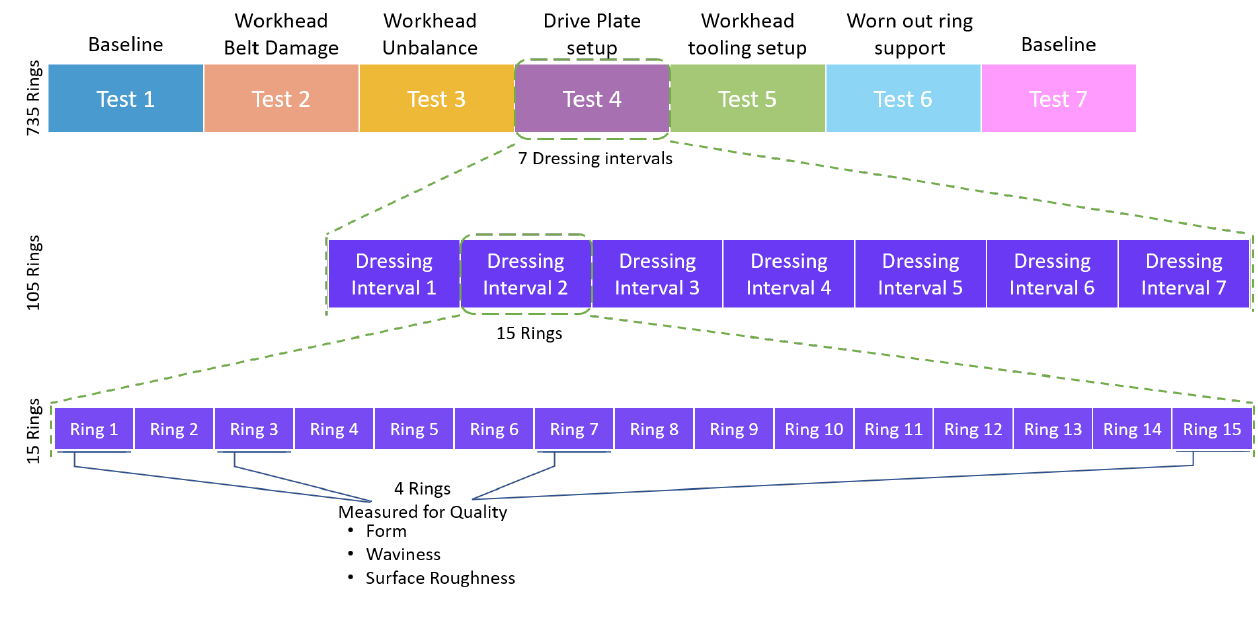
Figure 5. Grinding cycle to produce parts during tests. The grey line represents the grinding slide position as it moves into the workpiece. Blue represents the resulting in typical force/power signals and the segments that are extracted from each sensor signal for every cycle.